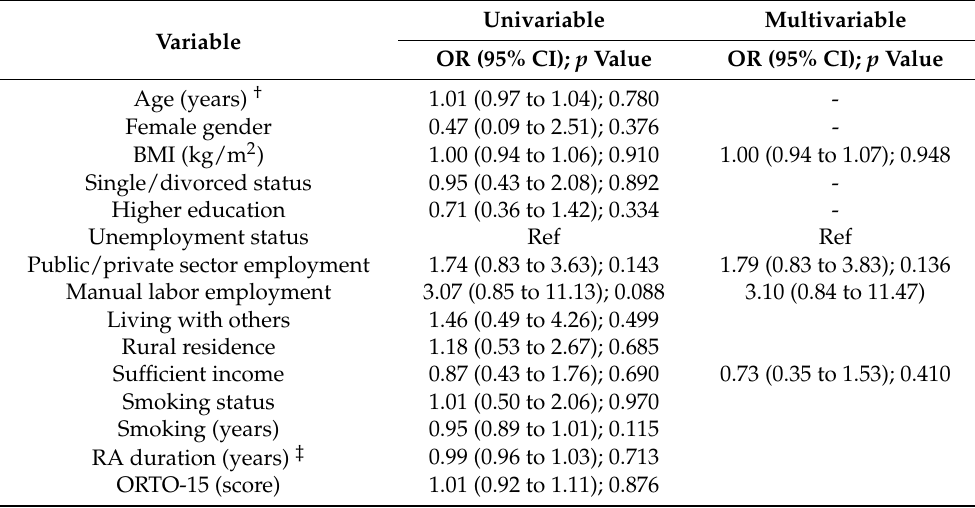
Table 3. Results of univariable and multivariable logistic regressions examining the association of study variables with reported remission status ( n =